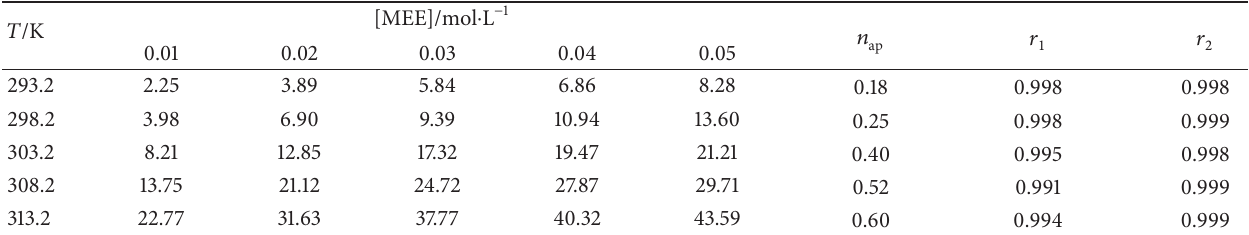
Table 1: 10 3 𝑘 /s − 1 varying with the different [MEE] at different temperatures. obs